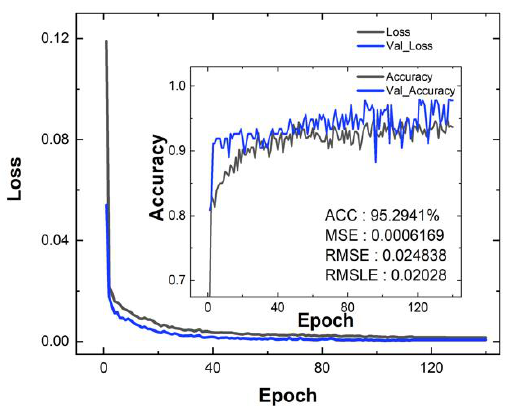
Figure 5. The loss approaches 0 as the epoch increases, and the accuracy according to the epoch exceeds 0.9. Table 2. Mean and standard deviation of the performance metrics.